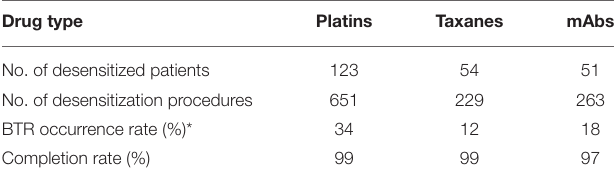
TABLE 2 | Outcomes of 1,143 cases of